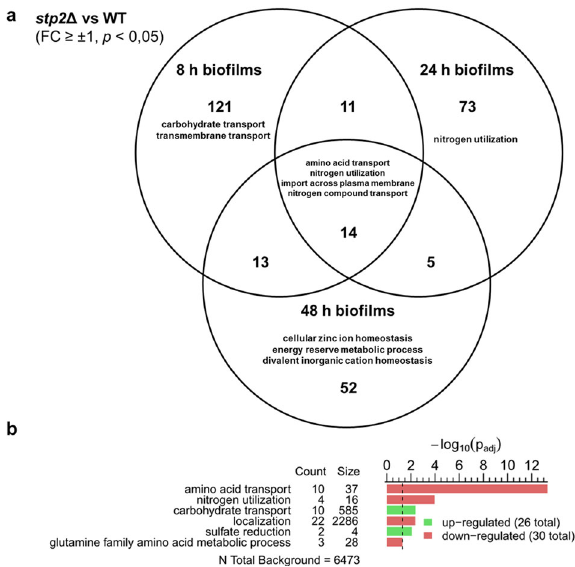
Fig. 7 Transcriptome analyses in stp2 Δ bio fi lms compared to the wild type under normoxia. Transcriptomes of stp2 Δ and wild-type bio fi lms grown for 8, 24, and 48 h under normoxic conditions and differentially expressed genes ( p < 0.05 and log 2 FC ± 1) were analyzed for GO term enrichments and summarized with REVIGO (dispensability < 0.5 and p < 0.05 were displayed). Source data are provided as a Source Data fi le. a VENN diagram of time point- speci fi c effects shows the biggest effects for stp2 Δ at early time points. b Time point-independent (time point as a confounding variable) differences were analyzed for genotype-speci fi c effects during bio fi lm